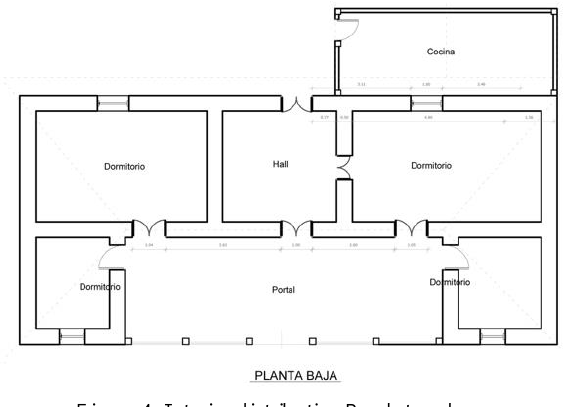
Figure 4. Interior distribution Porch type house, Nono, Ecuador, 2019.